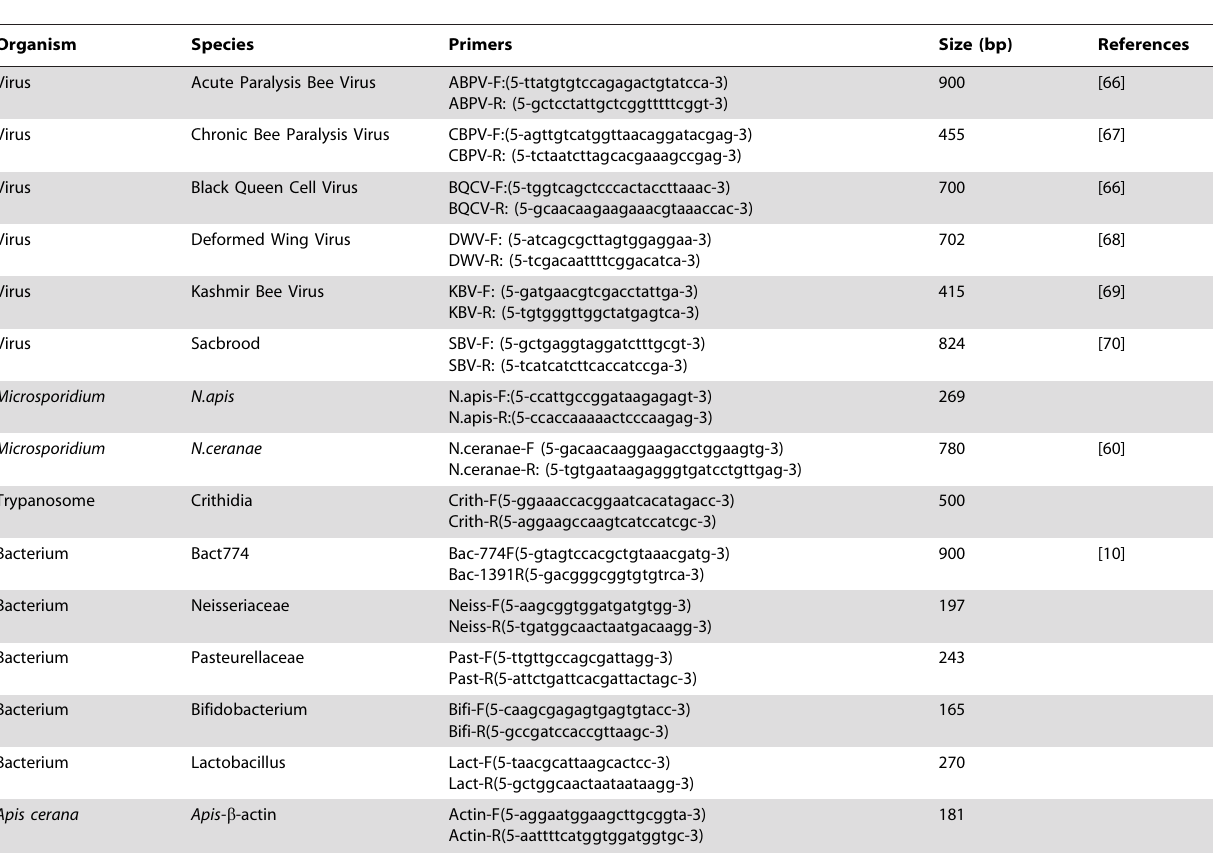
Table 1. Primers used for pathogen/parasite and microbiota detection and quantification.